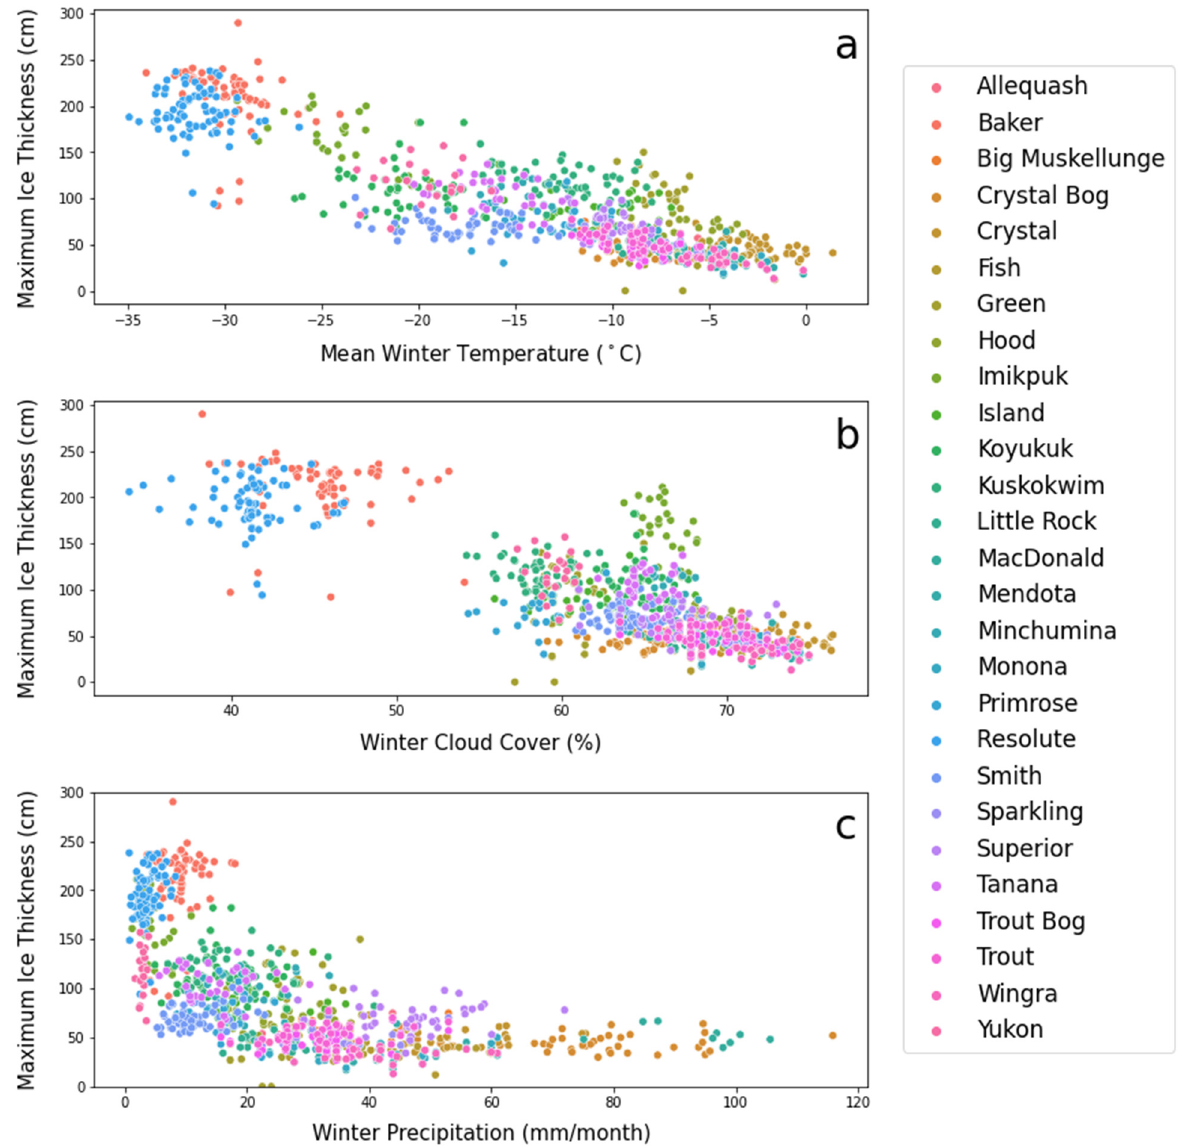
Figure 3. Maximum ice thickness (cm) against ( a ) mean winter air temperatures (°C), ( b ) winter cloud cover (%), and ( c ) winter precipitation (mm/month) for 27 waterbodies in North America. The different colors represent the lakes and rivers considered in the study.